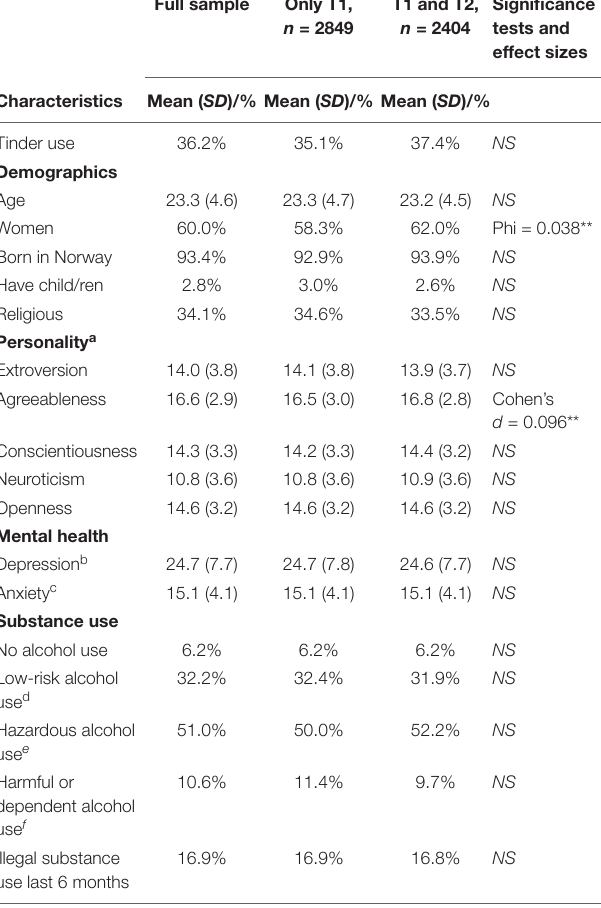
use characteristics among Tinder users ( n = 1666) and non-Tinder users ( n =